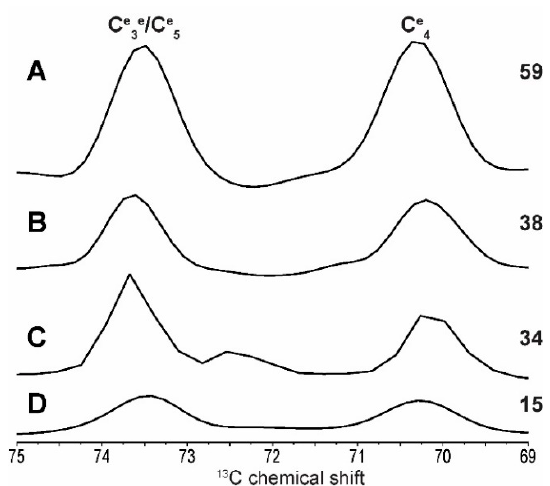
Figure 4. Traces corresponding to the C e3 /C e5 –C e4 correlation in non ‐ reducing end groups are extracted from 2D spectra with the C 4 area (see Figure 3) arbitrarily set to 100. Amylopectin ‐ rich ( A ), native ( B ), native retrograded ( C ) and amylose ‐ rich ( D ) starches traces are presented. C e4 intensities are indicated on the right.